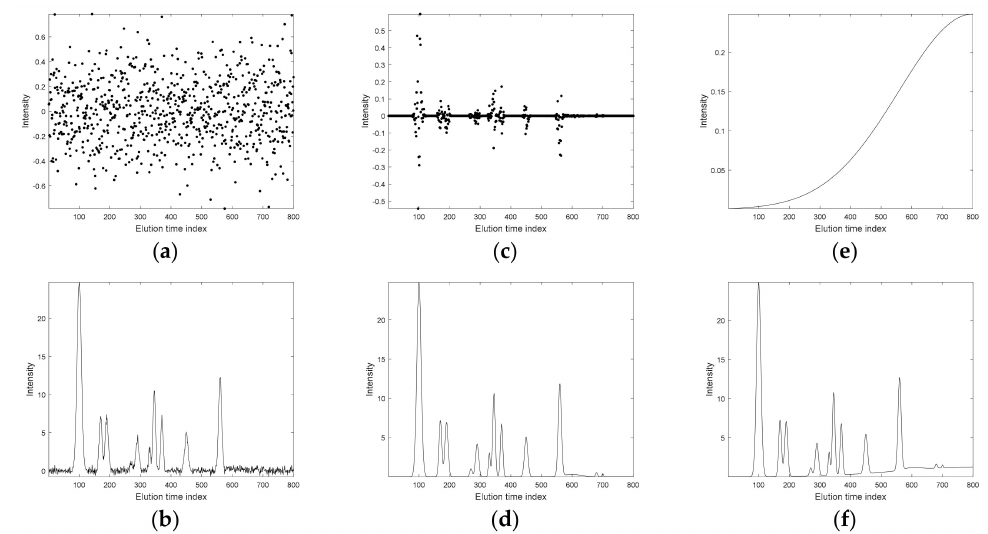
Figure 2. Effect of Gaussian noise, heteroscedastic noise, and baseline on the chromatogram of the first sample from a simulated data set: ( a ) simulated Gaussian noise and ( b ) chromatogram with Gaussian noise component, ( c ) simulated Gaussian noise (3.15% concerning the intensity of the largest peak), and ( d ) chromatogram with heteroscedastic noise component (2.4% concerning the intensity of the largest peak), ( e ) simulated baseline (5% concerning the intensity of the largest peak), and ( f ) chromatogram with a